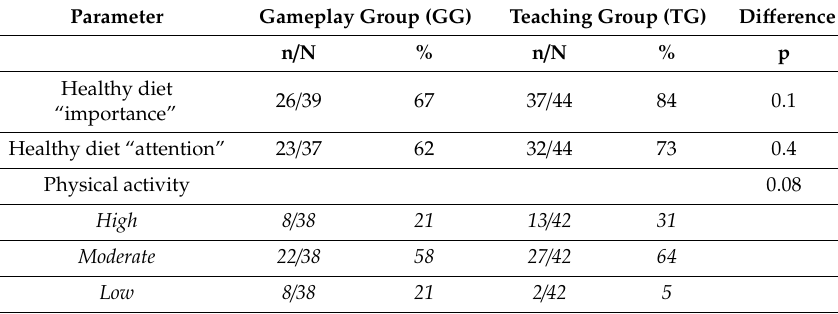
Table 3. Healthy diet attitudes and physical activity at